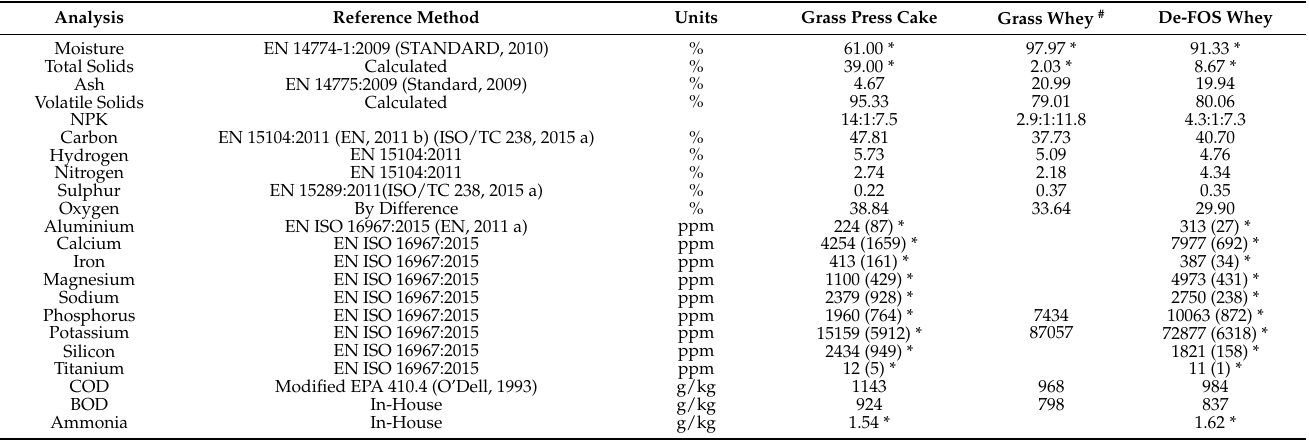
Table 1. Feedstock analysis for biorefinery